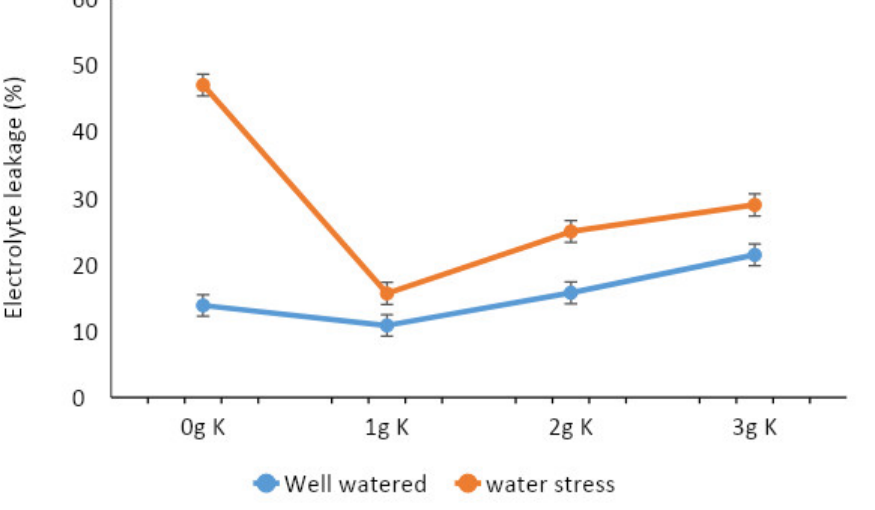
Figure 8. Effect of potassium on leaf electrolyte leakage of cocoa seedlings subjected to 35 days of water stress or well-watered conditions in a gauzehouse facility.